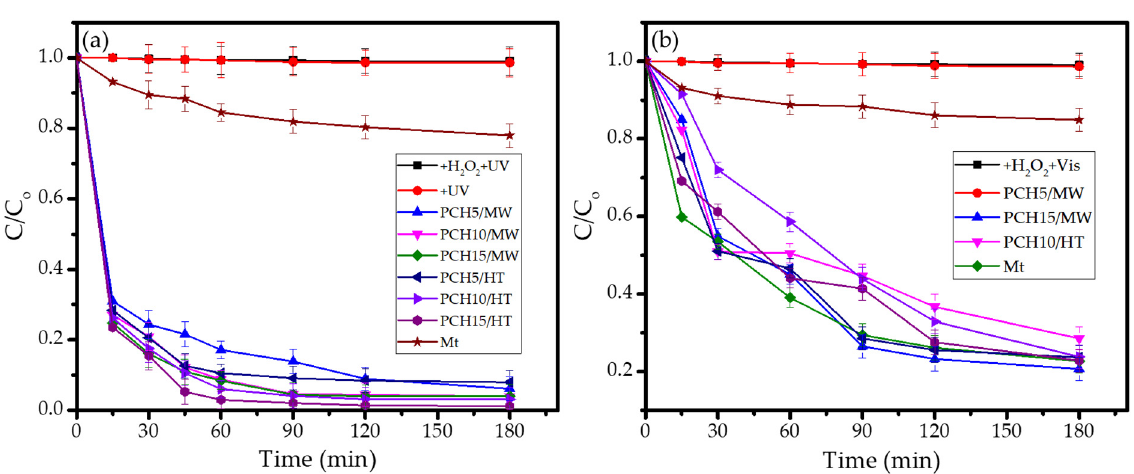
Figure 8. Kinetics of MV photodegradation over varied ZnO/SiO 2 -PCH samples in comparison with photolytic process and the treatment using Mt under ( a ) UV light; ( b ) visible light.